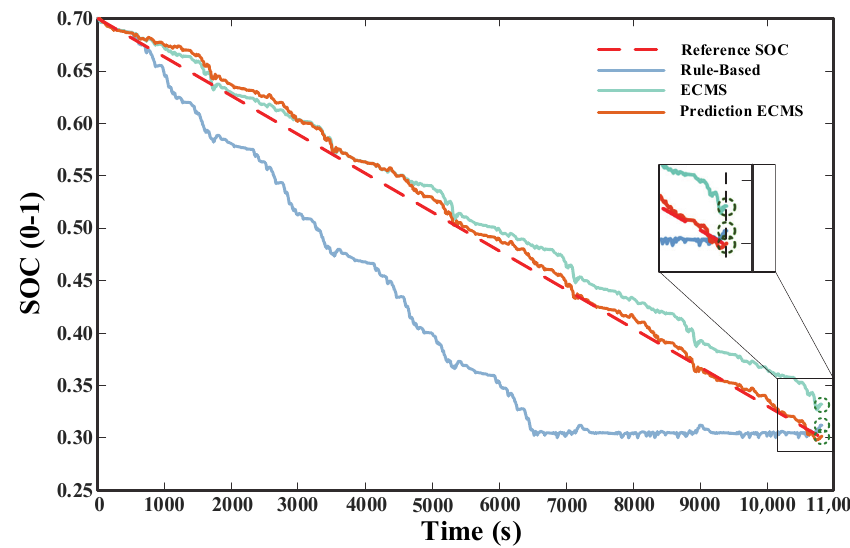
Figure 18. SOC decline trajectories under different strategies.